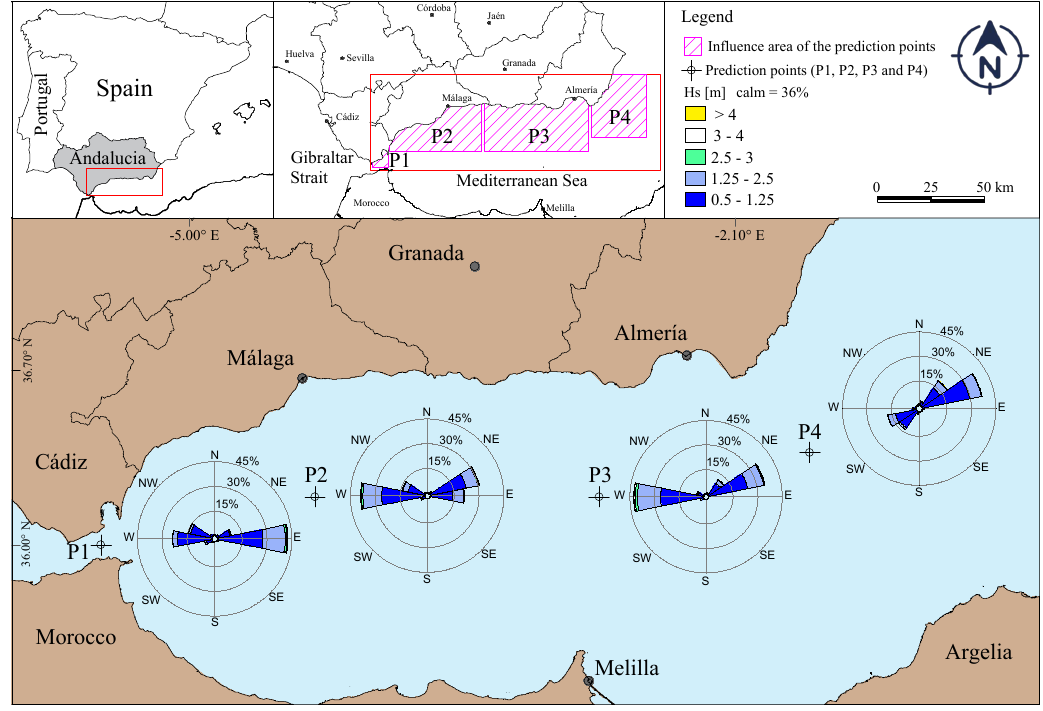
Figure 1. Geographic location of the study area and wave rise (1979–2014) for each prediction